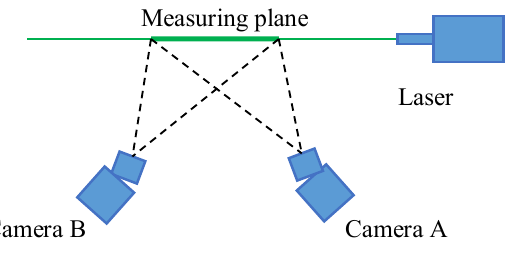
Fig. 2. Stereo PIV configuration .